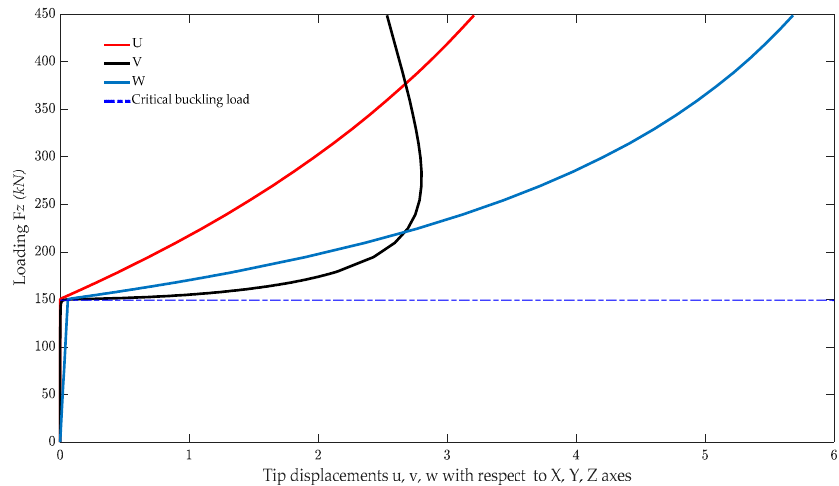
Figure 12. Load versus displacement curves for the cantilever beam with a downward concen- trated load.